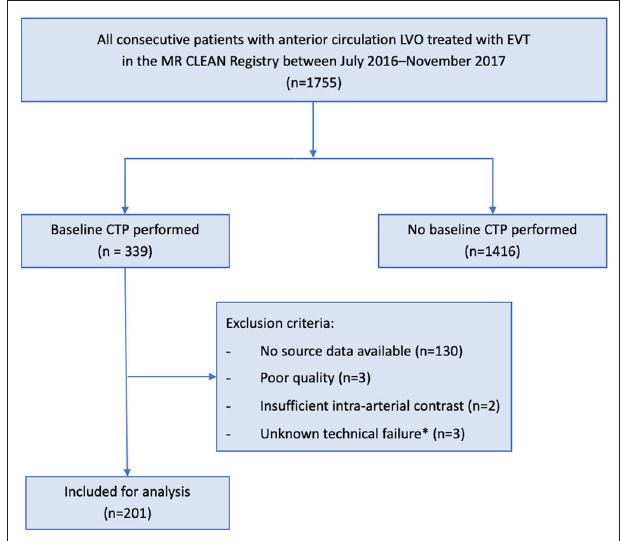
FIGURE 1 | Flowchart for patient selection. EVT, endovascular treatment; CTP, computed tomography-perfusion; MR CLEAN, Multicenter Randomized Controlled Trial of Endovascular Treatment for Acute Ischemic Stroke in the Netherlands. *Unknown scan data issue causing failure in post-processing software